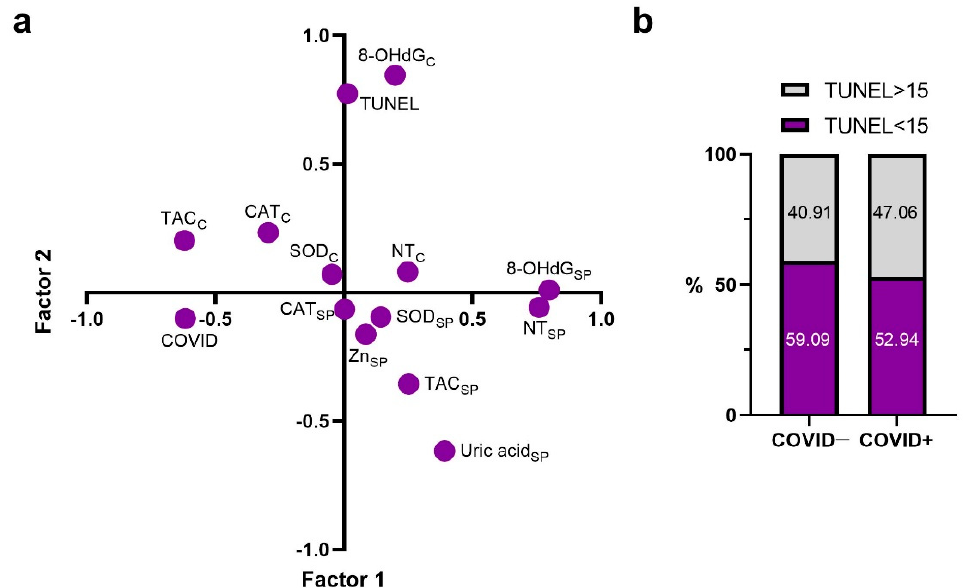
Figure 1. ( a ) A two-dimensional factor loading plot of the studied markers. 8-OHdG—8-hydroxy- 2 ′ -deoxyguanosine; CAT—catalase; NT—nitrotyrosine; SOD—superoxide dismutase; TAC—total antioxidant capacity; С (subscript)—cellular; SP (subscript)—in seminal plasma. ( b ) The plot of sample distribution with normal and abnormal TUNEL values in men after COVID-19 and without it.